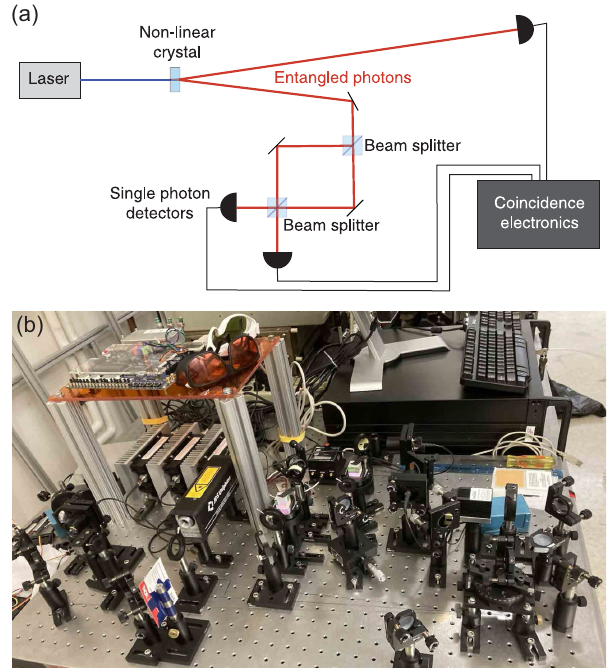
FIG. 1. The (a) schematic of the experiment and (b) photo of an actual experiment for the single-photon